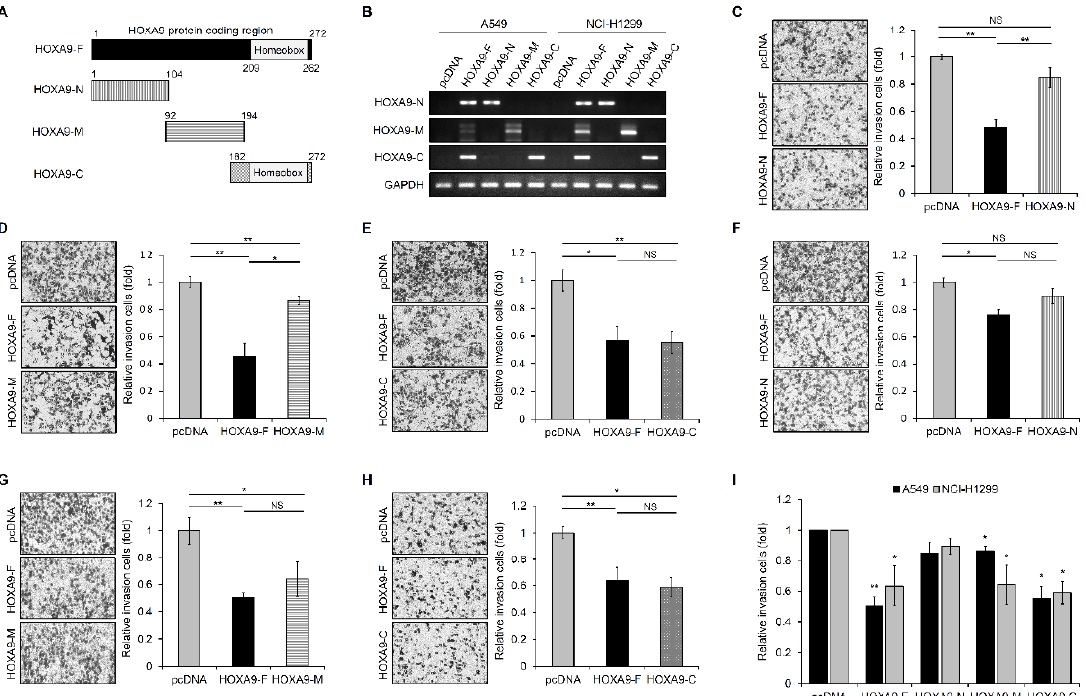
Figure 1. C-terminal fragment of Homeobox A9 (HOXA9) inhibits invasion of non-small cell lung cancer (NSCLC) cells. ( A ) Schematic representation of the cloned HOXA9 partial fragments. ( B ) The expression level of indicated partial fragments cloned into the expression vector. The expression was confirmed by the RT-PCR method in transfected A549 or NCI-H1299 cells. ( C – E ) Invasion assay with Boyden transwell chambers in the HOXA9 partial fragments transfected A549 cells. ( F – H ) Invasion assay in the HOXA9 partial fragments transfected NCI-H1299 cells. All images are shown at 200 × magnification. ( I ) Relative invasion values were obtained from all figure panels ( C – H ). All data represent the mean ± SD from three independent experiments. * p < 0.05; ** p < 0.01.